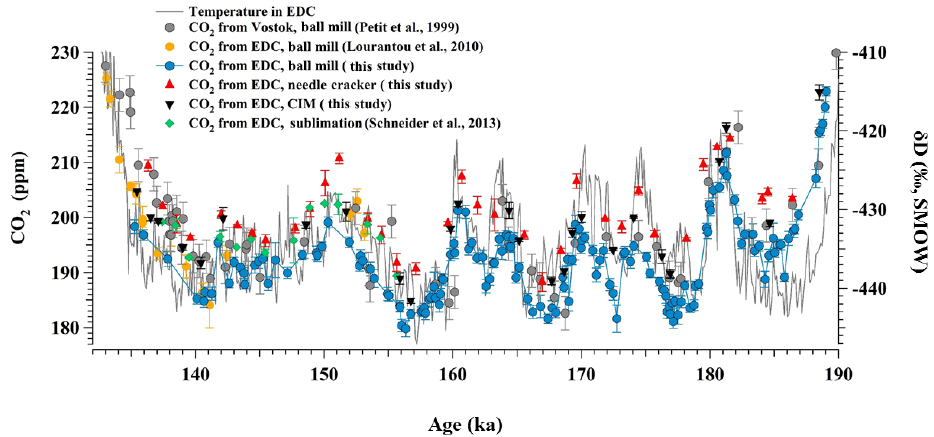
Figure 4. Atmospheric CO 2 from EDC and Vostok ice cores, compared to δ D of the ice in the EDC core (temperature proxy) during 190– 135ka. Blue dots represent atmospheric CO 2 from EDC as measured by the ball mill system (this study). The error bars of the new CO 2 data using the ball mill extraction system indicate the standard deviation of five consecutive injections of the gas extracted from each sample into the gas chromatograph added to the precision of the measurement estimated by the reproducibility of the control measurement ( ∼ 0 . 8ppm) using a quadratic sum. Yellow dots represent atmospheric CO 2 from EDC measured using the ball mill system (Lourantou et al., 2010). The error bars indicate the standard deviation of five consecutive injections of the gas extracted from each sample into the gas chromatograph. Red triangles represent atmospheric CO 2 from EDC measured using the needle cracker (this study). The error bars of data points with replicates indicate the standard deviation of the mean of replicates from the same depth interval. Black inverted triangles represent atmospheric CO 2 from EDC measured using the CIM (this study). The error bars of data points with replicates indicate the standard deviation of the mean of replicates from the same depth interval. Green diamonds represent atmospheric CO 2 from EDC measured using sublimation extraction (Schneider et al., 2013). The error bars of data points with replicates indicate the standard deviation of the mean of replicates from the same depth interval (Schneider et al., 2013). Grey dots represent atmospheric CO 2 from the Vostok ice core (Petit et al., 1999). The error bars of the CO 2 data from Vostok (Petit et al., 1999) show the estimated overall accuracy for CO 2 measurements. The grey line represents δ D of ice in the EDC core (Jouzel et al., 2007).